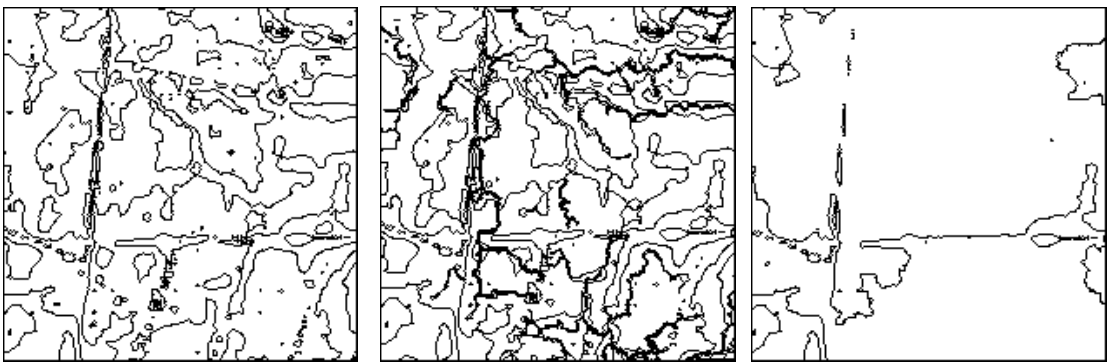
Figure 6. Relief with contour lines, Nijemci DTM5 (left- a), after the pit removal by carving method (middle - b) and after the pit removal by filling method (right - c)